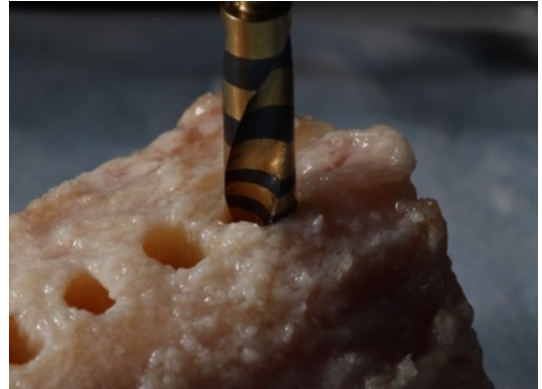
Figure 5. Each osteotomy was prepared with at least 2 mm of bone separating adjacent